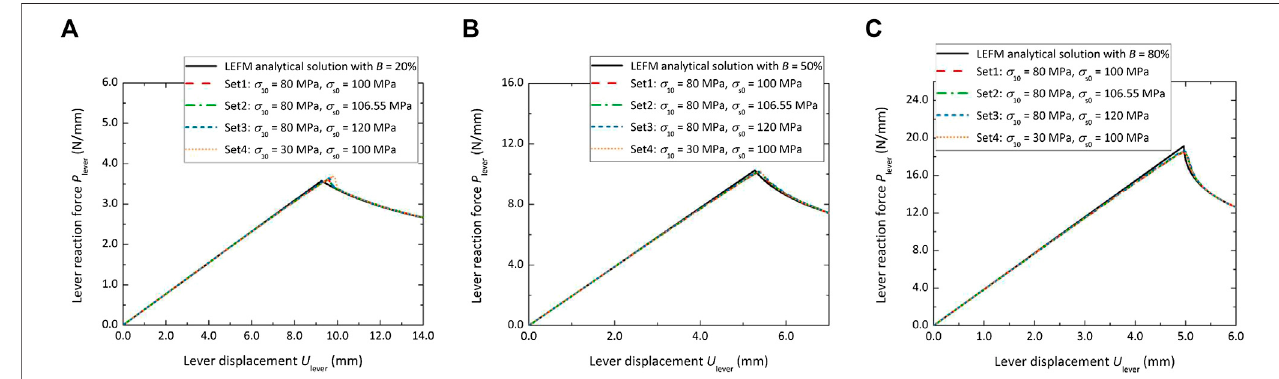
FIGURE5| Thedependence oftheload-displacement curveontheinter-laminarnormalandshearstrengthwith: (A) modemixityof20%; (B) modemixityof50%; (C) mode mixity of 80%.